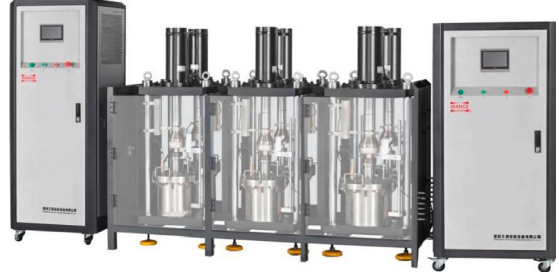
Figure 8: Rock rheological test system controlled by microcom- puter under multichannel combined axial pressure and water pressure.